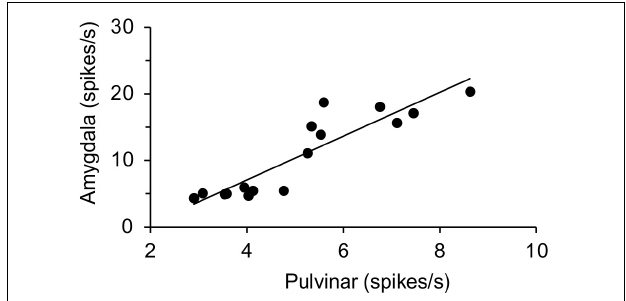
FIGURE 5 | Linear correlation of response magnitudes between the pulvinar and amygdala. Response magnitudes to the same 16 stimuli in the amygdala and those in the pulvinar (Le et al., 2013) are plotted. There was a significant positive correlation between the amygdala and pulvinar in response magnitudes ( p < 0.0001).